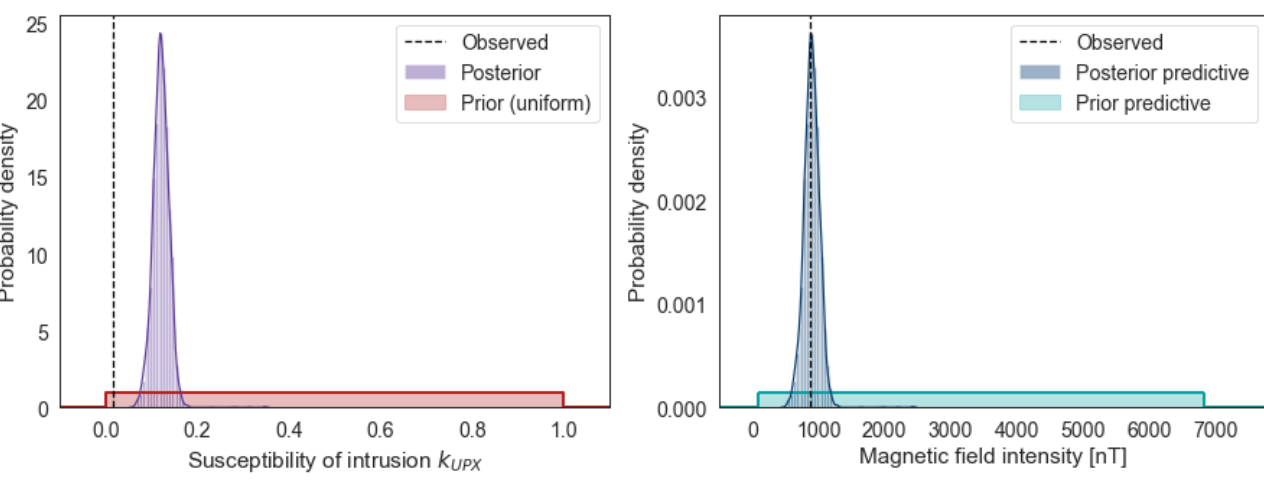
Figure 6. ( Left ) Pdf with prior and posterior distribution of k UPX , and the mean of the downhole measured susceptibility for k UPX (dashed line). ( Right ) Pdf with prior and posterior predictive distribution as simulated at one of the observation locations, and the measured magnetic intensity at that observation location (dashed